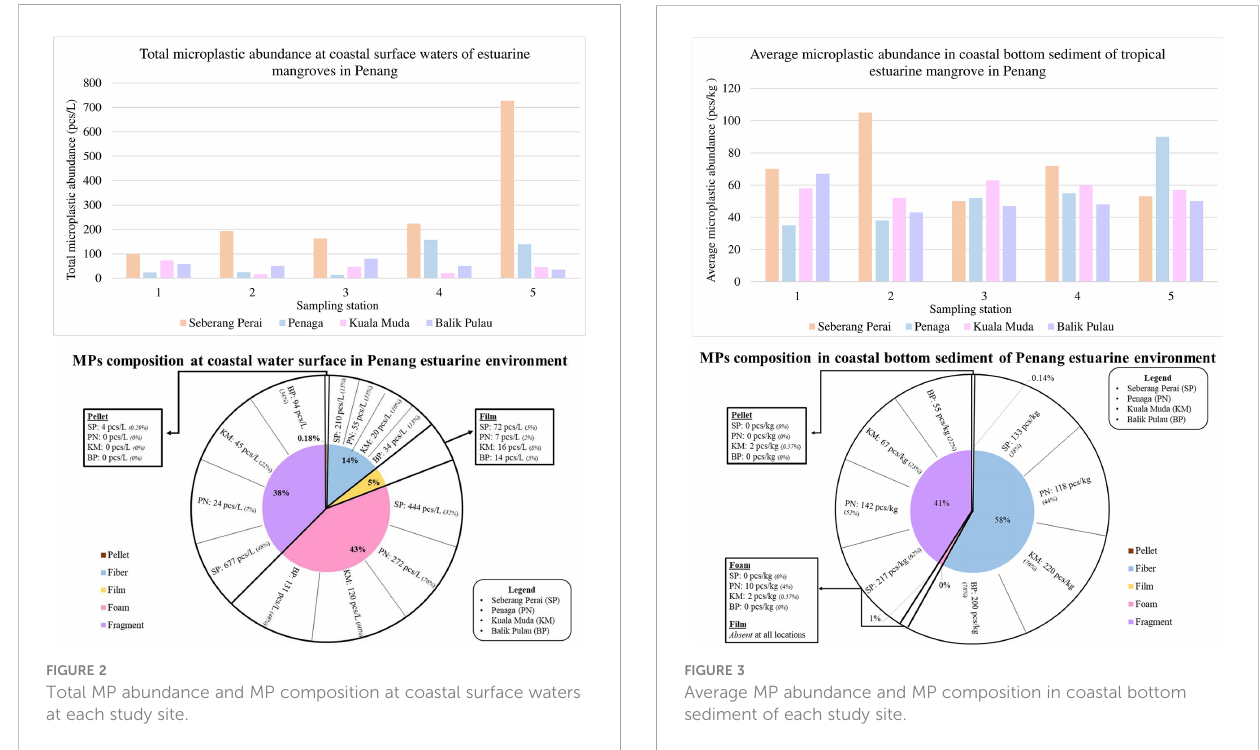
FIGURE 2 Total MP abundance and MP composition at coastal surface waters at each study site.